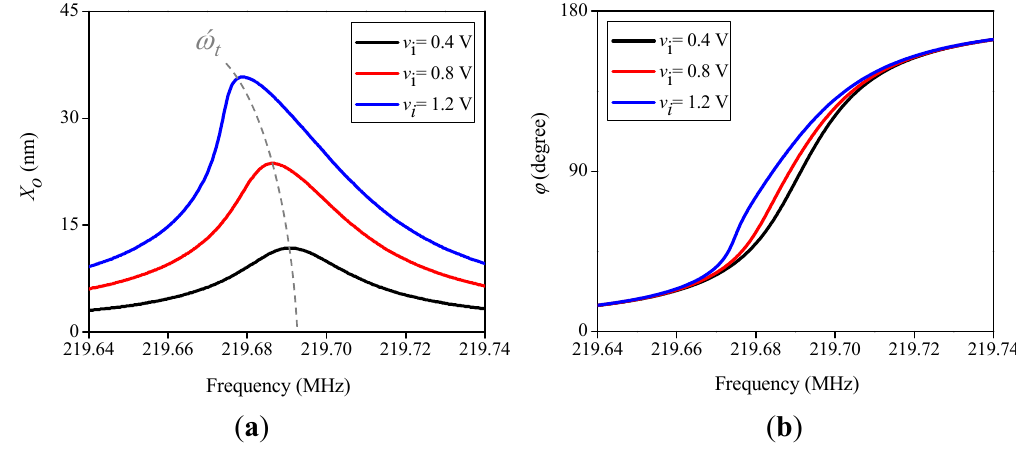
Figure 9. ( a ) The effect of quality factor on frequency response for EWG ring resonator = 100 V and v = 1 V; ( b ) The jump phenomenon due to the frequency with d = 90 nm, V P i hysteresis at Q =